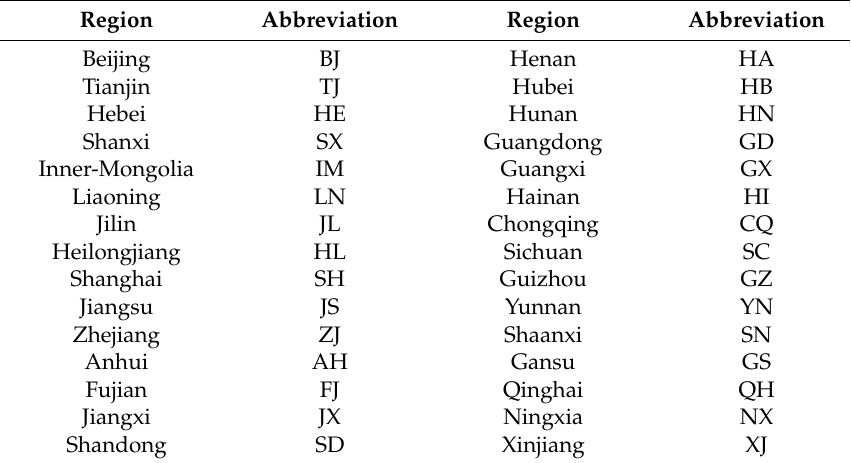
Table 2. Abbreviations of the 30 study regions in